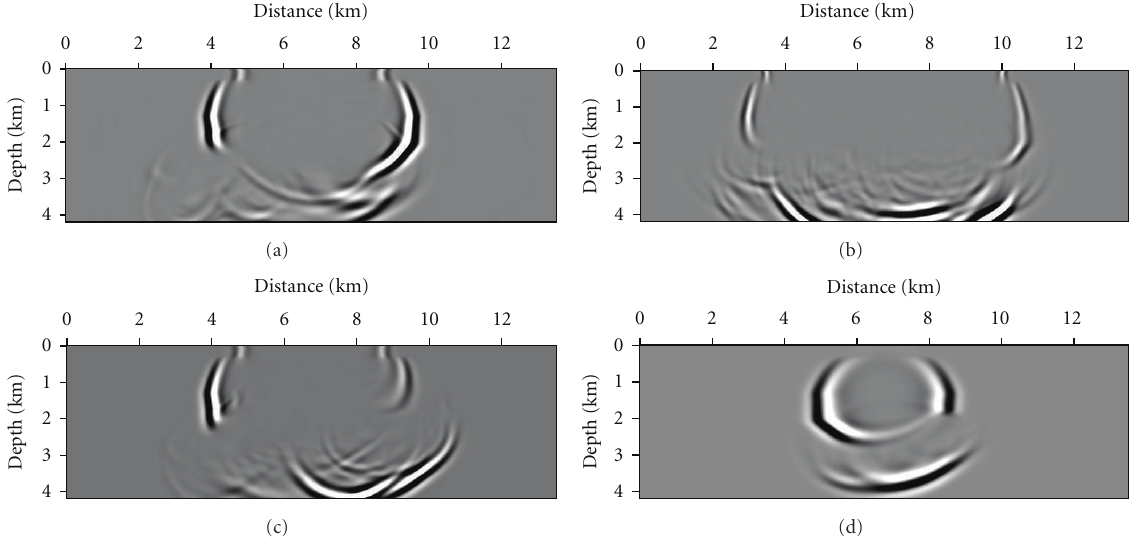
Figure 5: Impulse response of FFD migration with two-way splitting. Vertical cuts as in Figure 3.